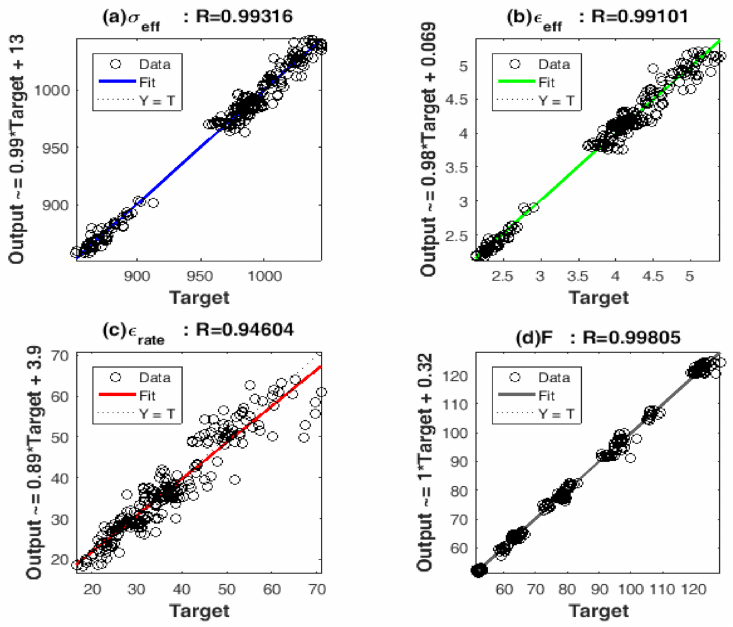
Figure 5. Post-regression analysis with 226 training patterns for: ( a ) E ff ective stress; ( b ) E ff ective strain; ( c ) E ff ective strain rate; and ( d ) Punch